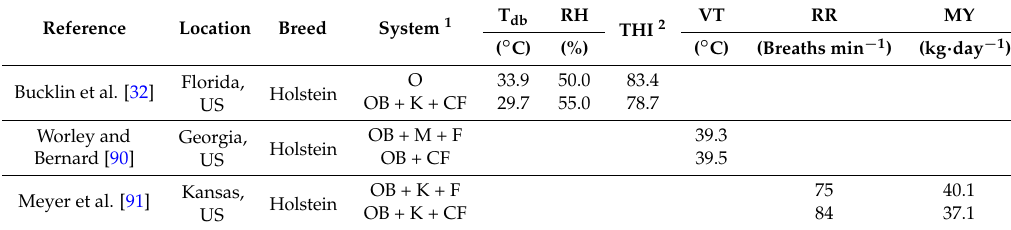
Table 9. Meteorological attributes, THI calculations, and physiological response of dairy cows for control treatments and barns equipped with ceiling